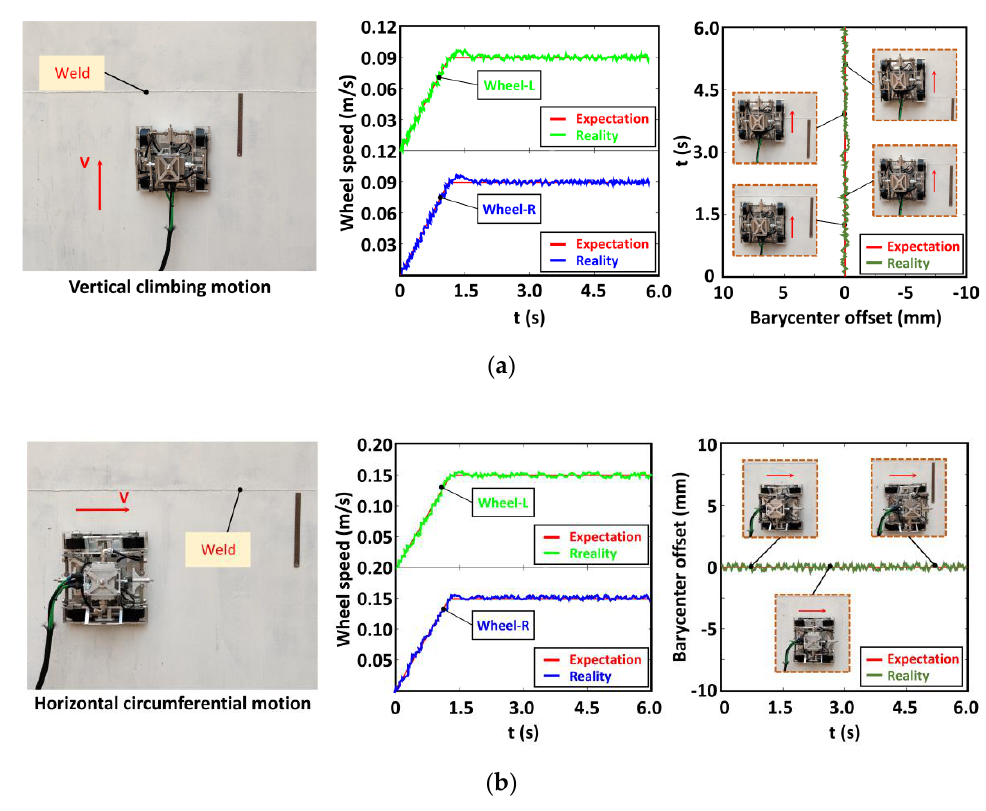
Figure 12. Experimental of wall motion: ( a ) Vertical upward climbing motion test and ( b ) horizontal circumferential motion circumferential motion test.